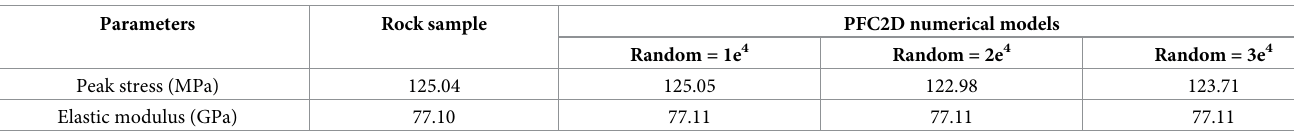
Table 2. Peak stress and elastic modulus under different random seeds.